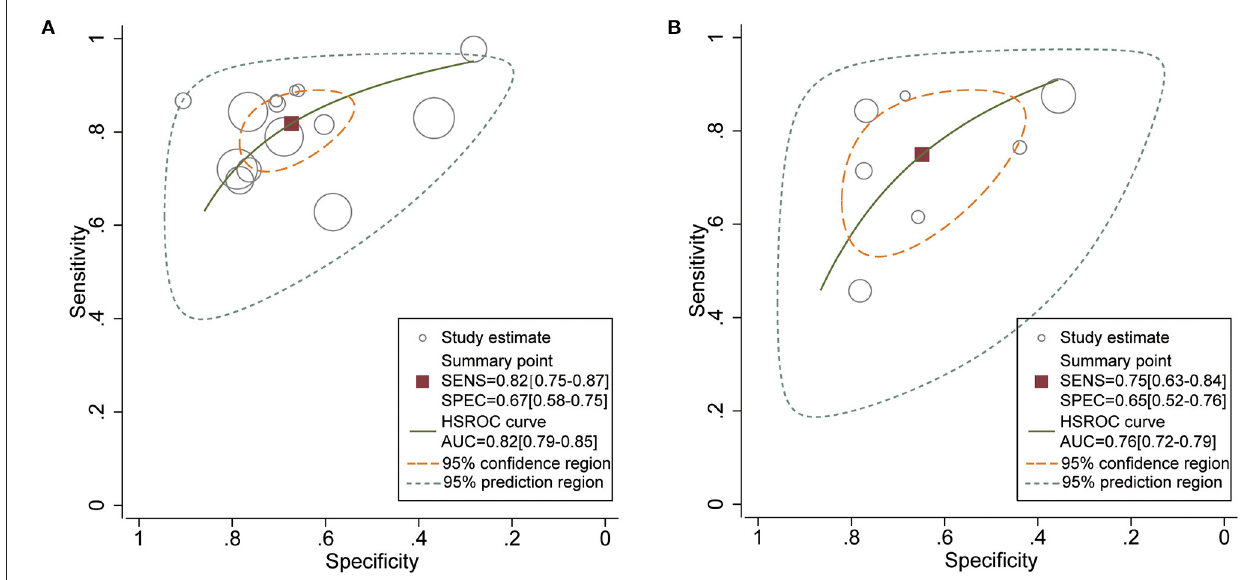
FIGURE 4 | Hierarchical summary ROC curves for (A) National Early Warning Score 2 (NEWS2) and (B) National Early Warning Score (NEWS) for predicting clinical deterioration in patients with COVID-19.